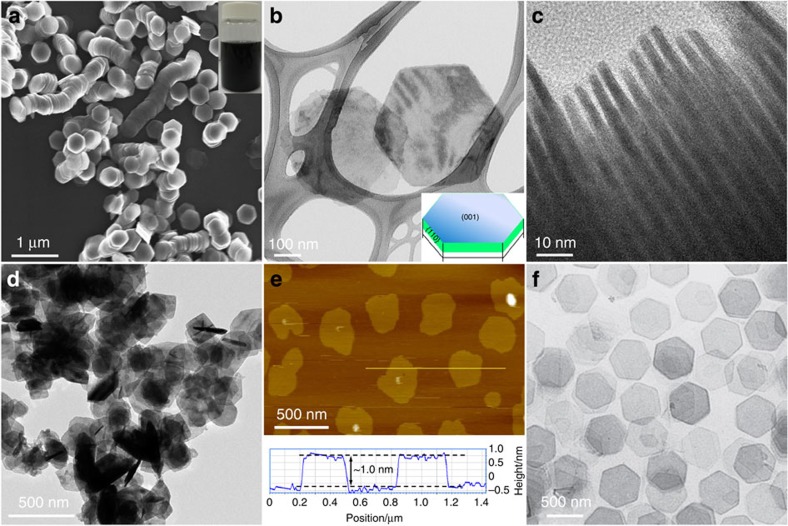
2D nanosheets synthesized using soft colloidal templated synthesis and other methods.(a) SEM image of ultrathin CuS nanosheets. Inset: photograph of the colloid solution of CuS nanosheets. Adapted from ref. 77. TEM images of ultrathin CuS nanosheets with (b) lying flat and (c) standing on the TEM grids. Inset in b: scheme of an ultrathin CuS nanosheet. Adapted from ref. 77. (d) TEM and (e) AFM images of SnSe nanosheets. Adapted, with permission, from ref. 78 (Copyright 2013 American Chemical Society). (f) TEM image of Pd nanosheets. Adapted from ref. 81.